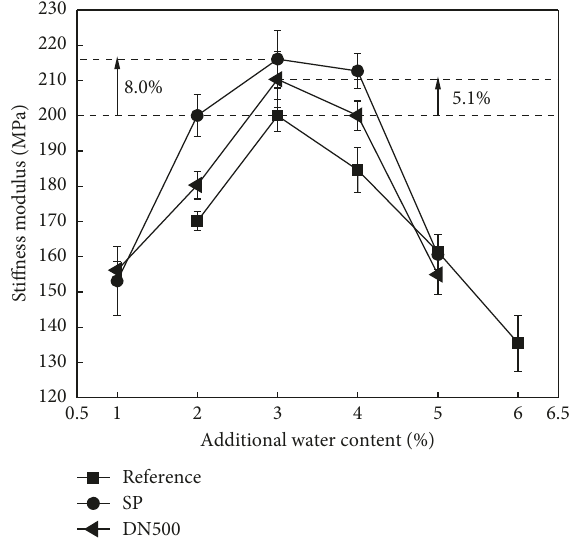
Figure 10: The stiffness modulus of CRME with different addi- tional water contents and